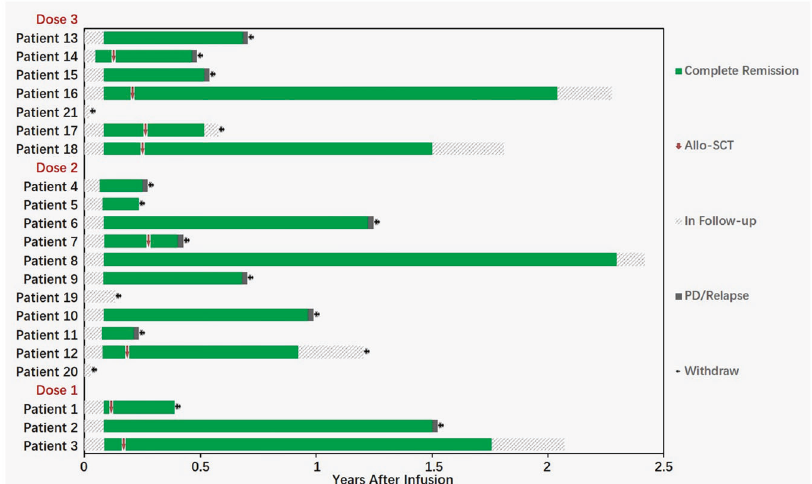
Fig. 5 Data for survival and use of allo-HSCT after CAR-T cell treatment for patients with R/R B-ALL enrolled in the clinical study ( n = 21). All 18 ef fi cacy-evaluable patients (100%) were followed for at least 3 months; 15 of these patients (83.3%) maintained disease-free survival (DFS) at the 3-month assessment, and 14 patients (77.8%) remained MRD negative at 3 months. The longest time of disease-free survival was 29